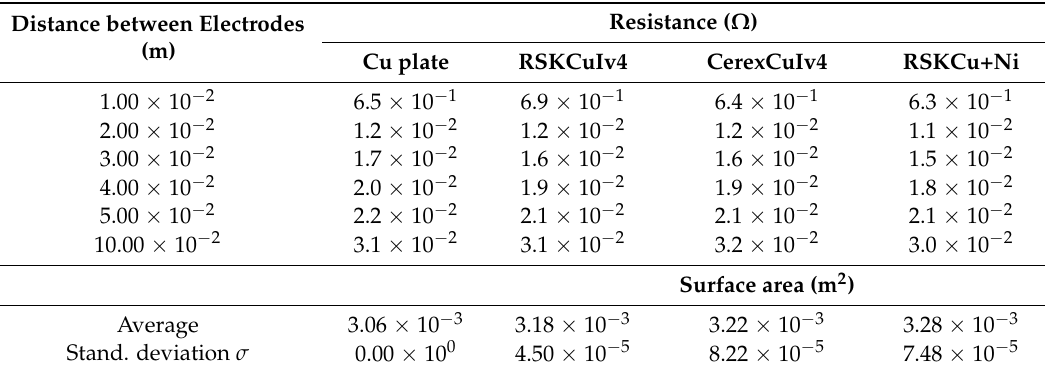
Stand. deviation